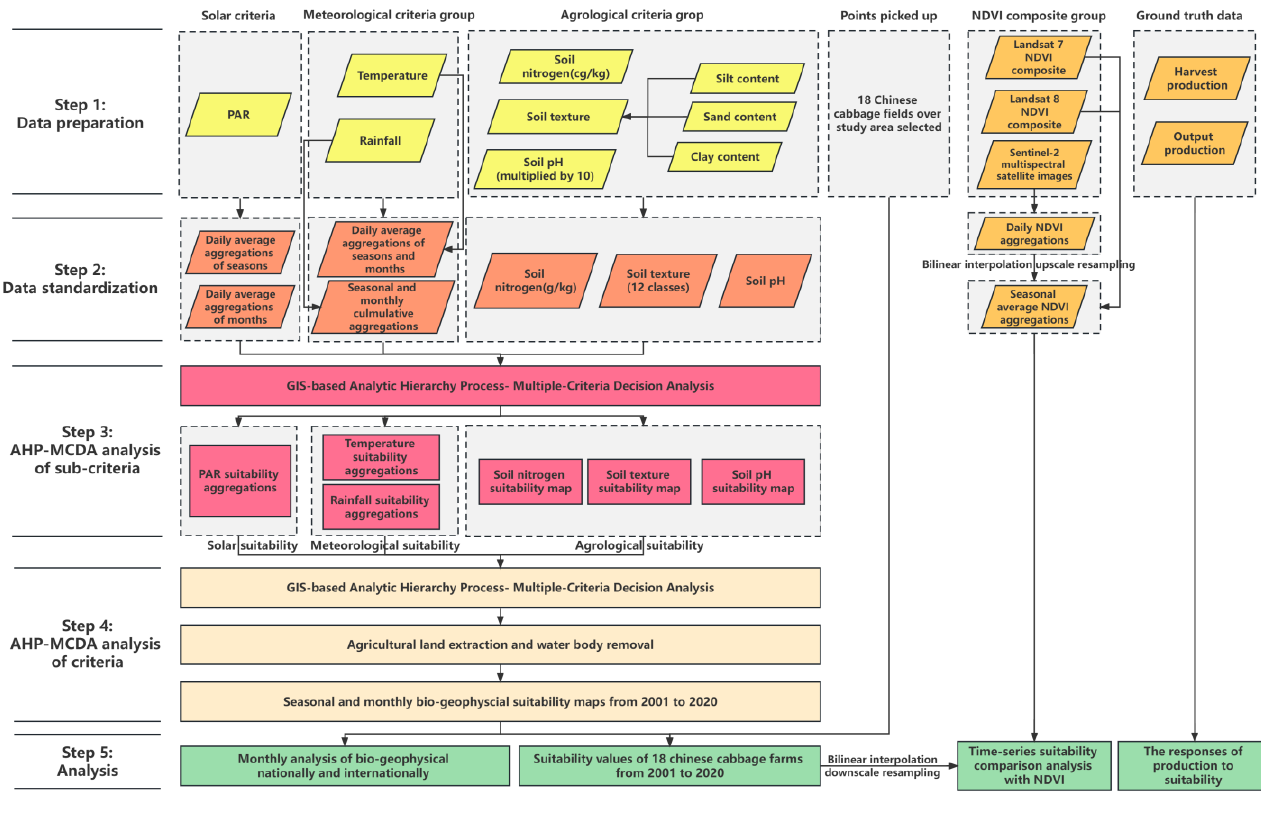
Figure 2. Overflow of this